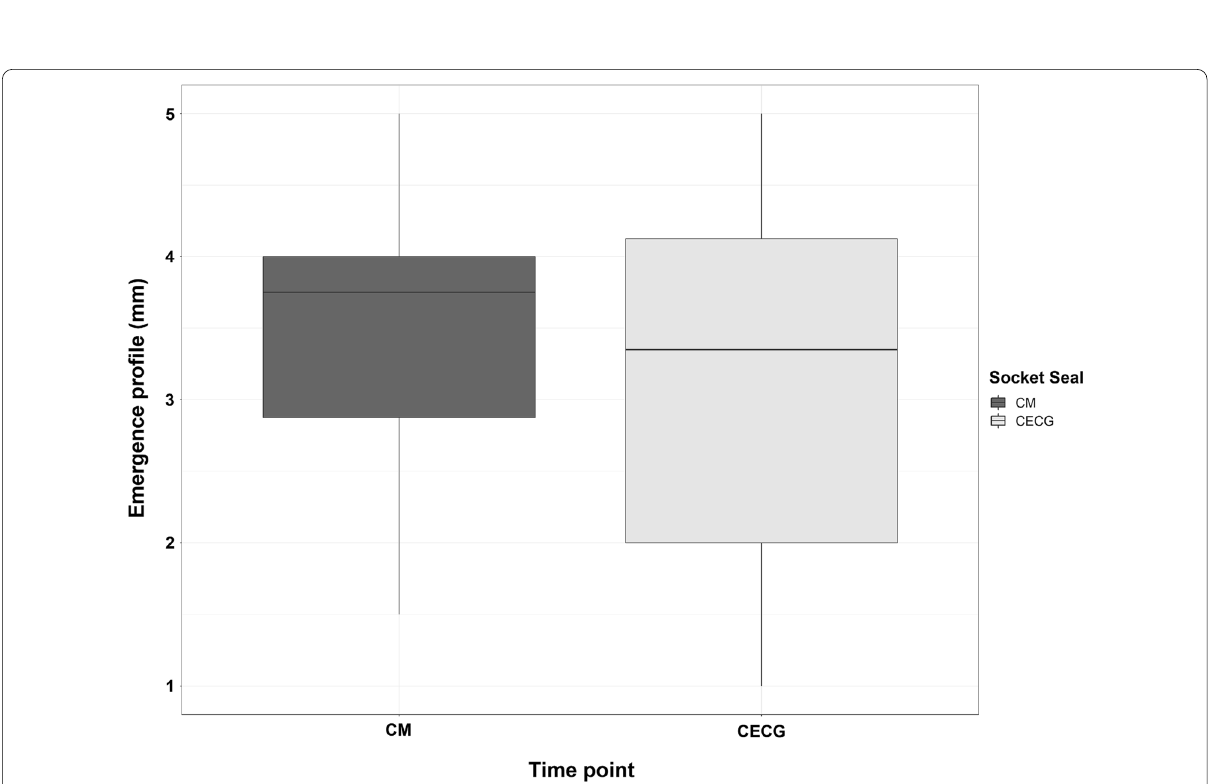
Fig. 5 Comparison of emergence profile in both groups after second stage surgery